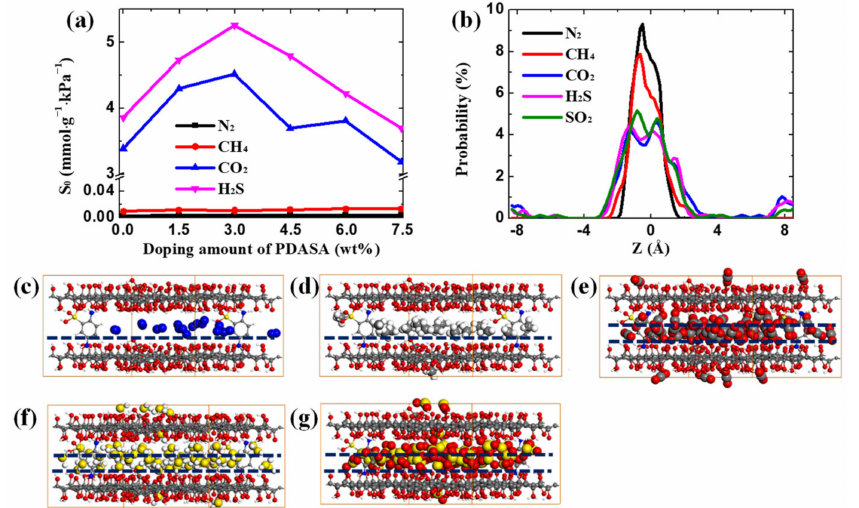
Figure 3. Adsorption behavior. ( a ) Solubility coefficient of different gases in GO membranes. ( b ) Distribution probability of gases in GO channels. Snapshots of variable gases adsorbed in GO channels. ( c ) N 2 ; ( d ) CH 4 ; ( e ) CO 2 ; ( f ) H 2 S and ( g ) SO 2